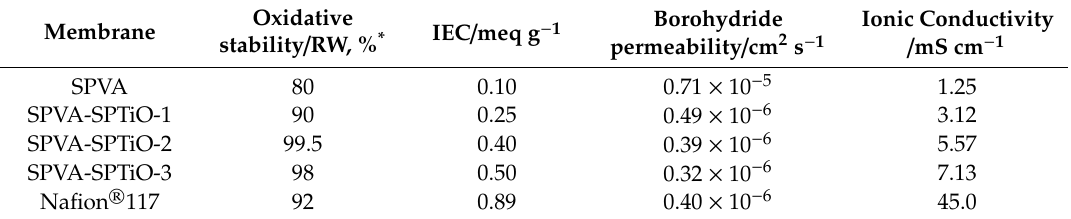
Figure 10. Impedance measurements of the doped membranes and of the undoped membrane.